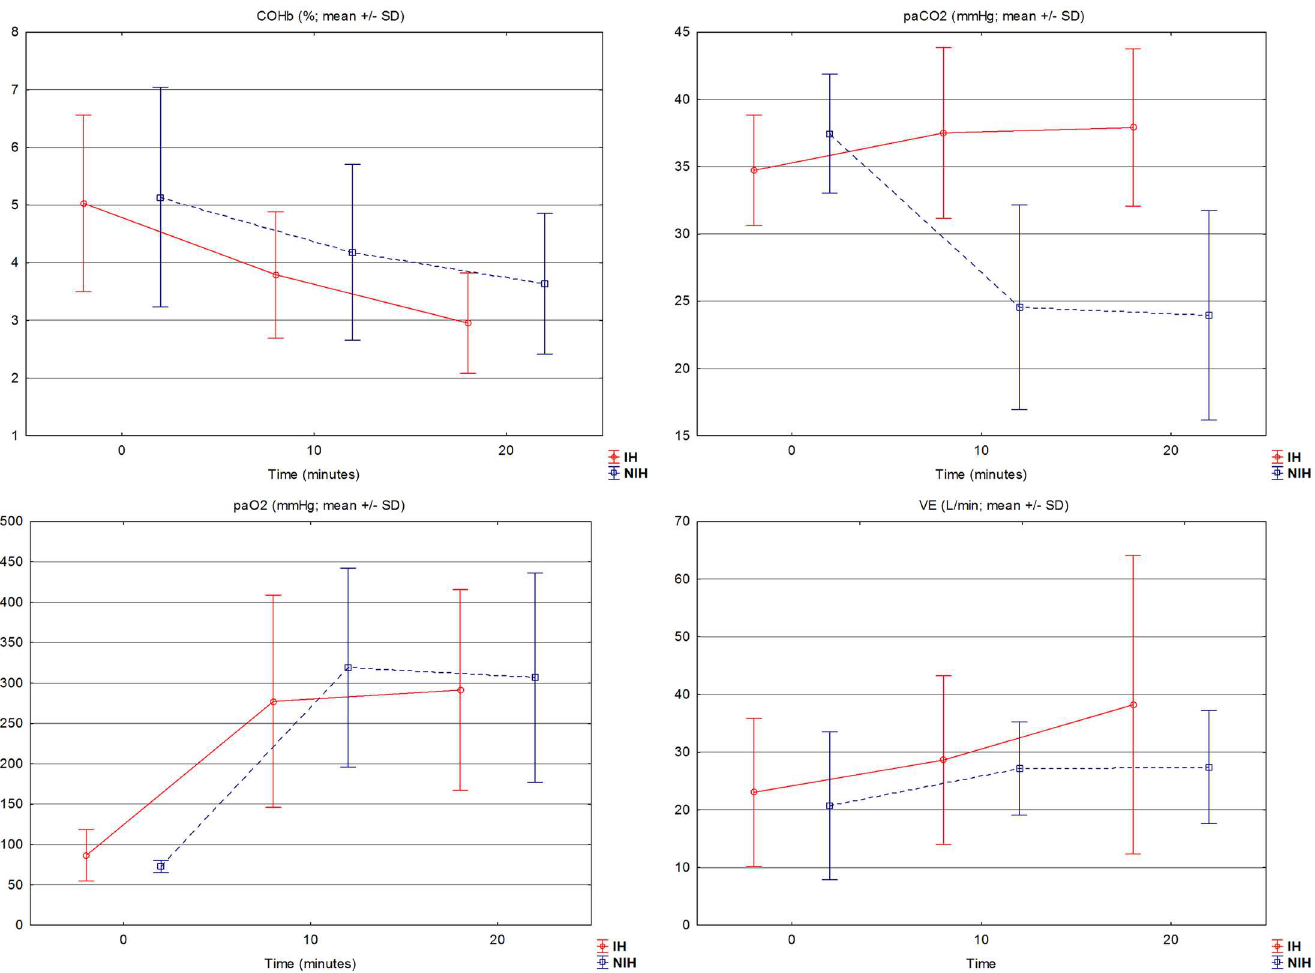
Fig 2. Selected parameters(COHb, paCO2, paO2 and VE) during the procedures (mean ± SD). Comparison of selectedparametersduring IH and NIH at 0, 10 and 20 minutes: COHb—carboxyhemoglobinlevel (%), paCO2 –partialpressure of carbondioxidein capillaryblood (mmHg), paO2—partial pressureof oxygen in capillaryblood (mmHg), VE—total minute ventilation(L/min).